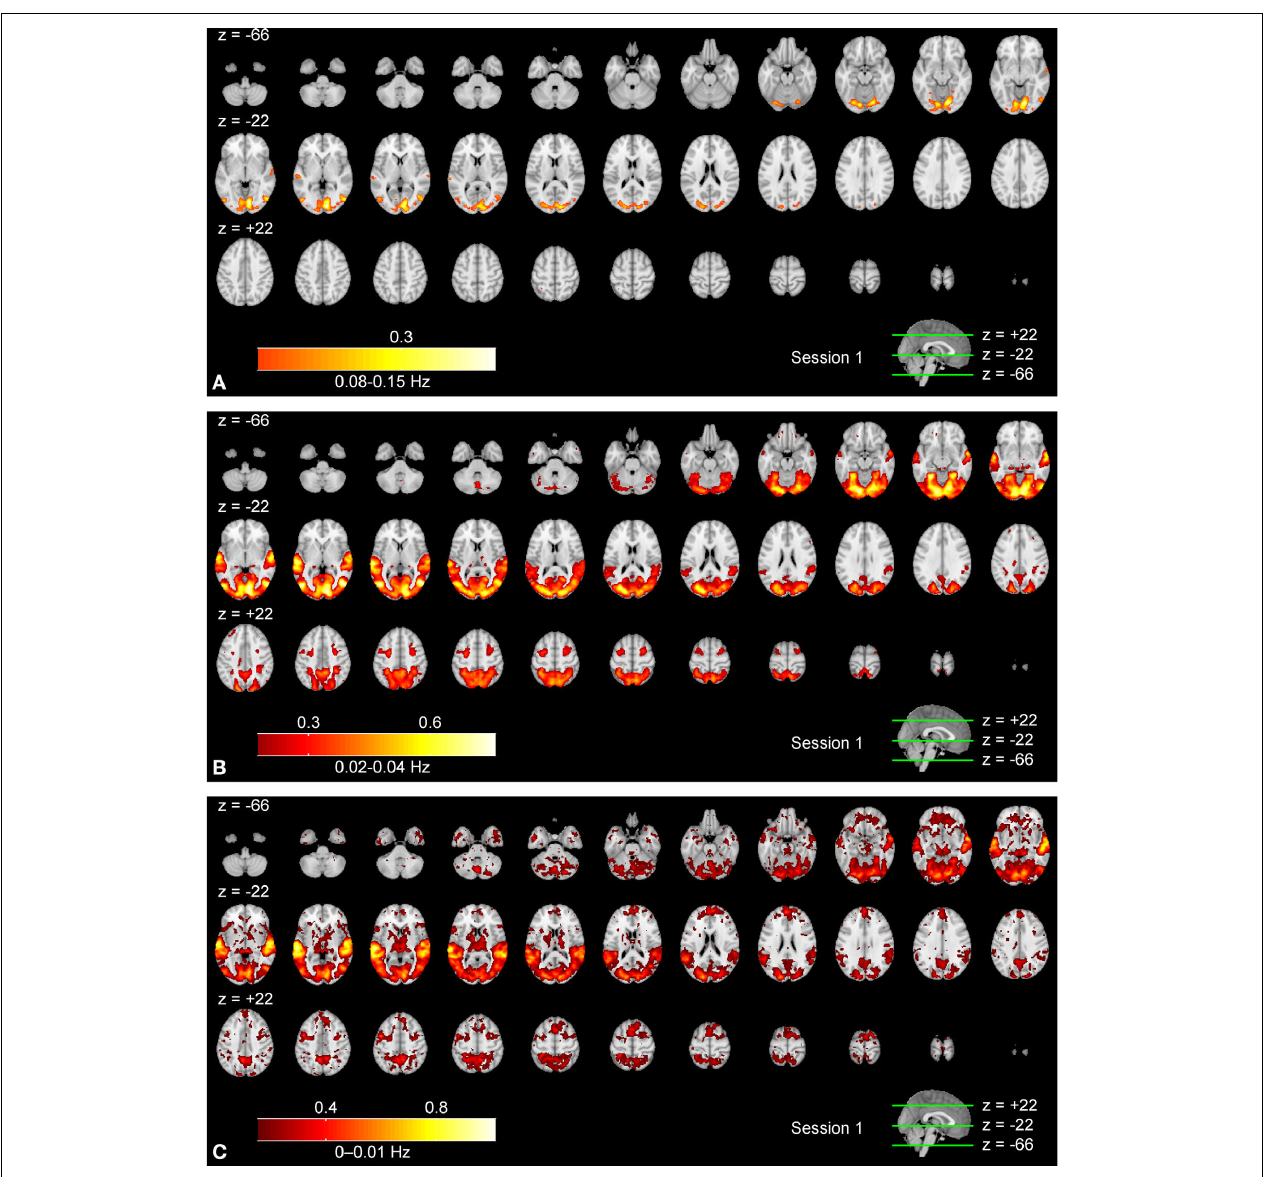
FIGURE 3 | Frequency-specifi c ISC maps ( p < 0.001, FDR corrected across the whole brain) in the range: (A) 0.07–0.15 Hz, (B) 0.02–0.04 Hz, and (C) 0–0.01 Hz. From top left to bottom right, axial slices are shown from z = − 66 to 62 mm (in MNI-coordinates) with 4 mm slice